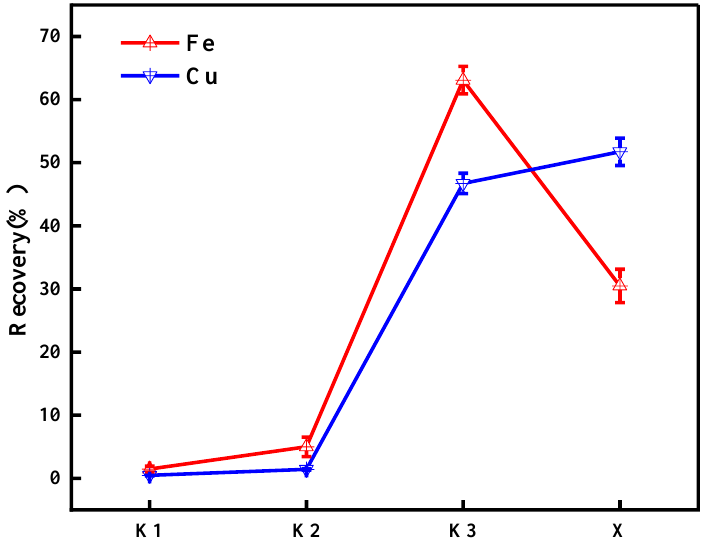
Figure 10. The iron and copper recovery from magnetic concentrates and tailing.